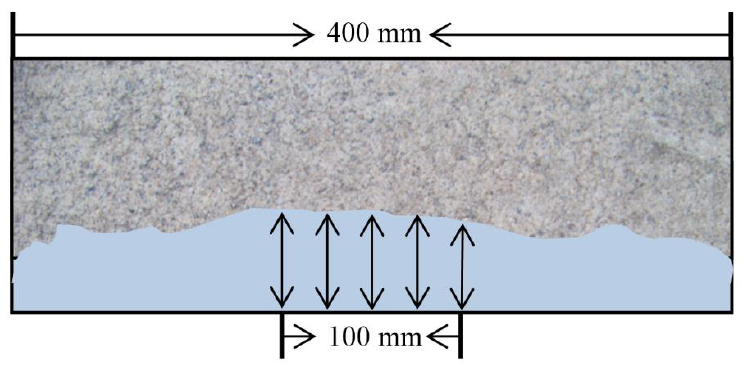
Figure 3. Sketch of the silver nitrate colorimetric method (depth measurement).